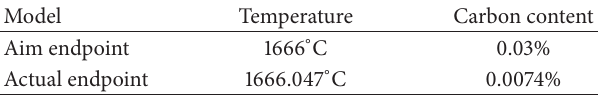
Table 8: The endpoint values of temperature and carbon